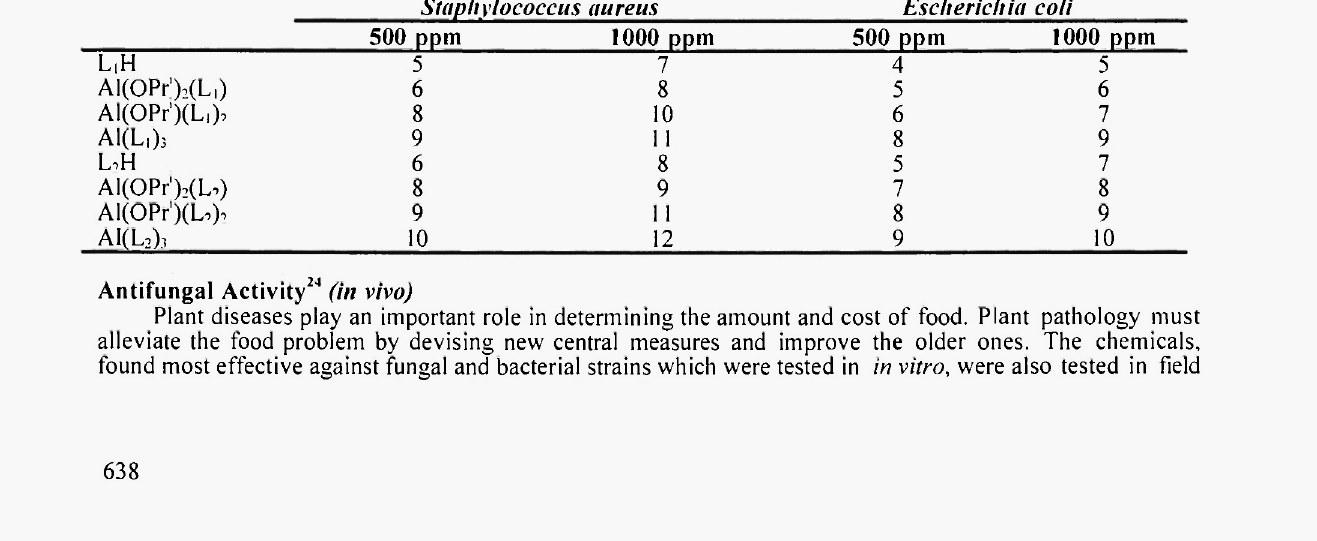
Table 3: Bactericidal Screening Data of Hydrazines and their Metal Complexes.